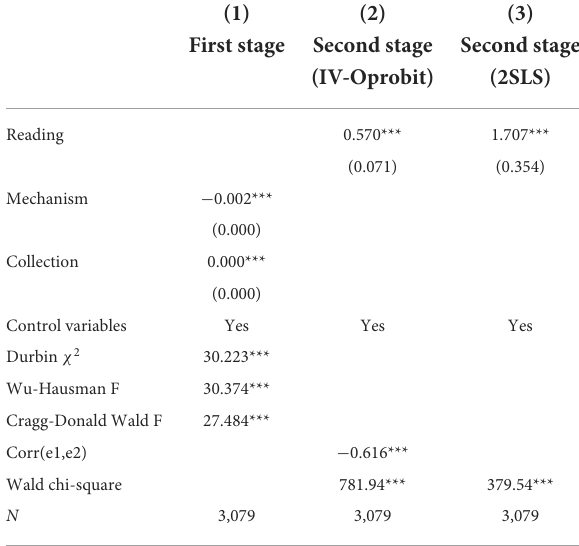
TABLE 3 Endogenous test of the influence of reading habits on physical and mental